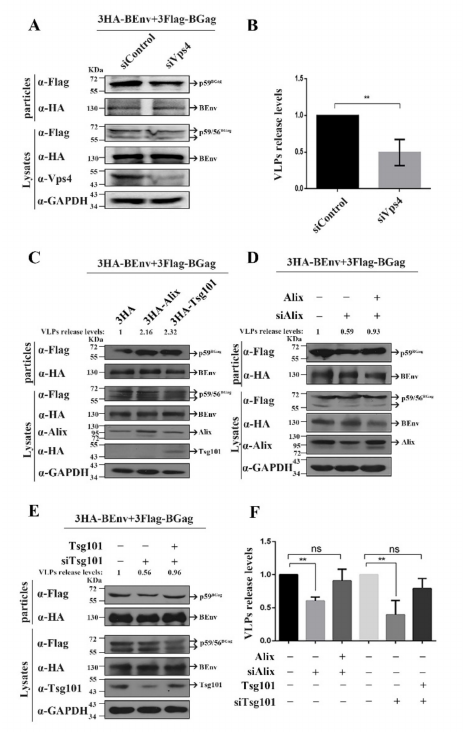
Figure 1. Effect of Vps4, Tsg101, or Alix proteins on particle budding. ( A ) HEK293T (4 × 10 6 ) cells were transfected with si VPS4 or siControl 6 h before being transfected with 3HA-BEnv or 3Flag-BGag (BFV Gag protein), and then cultured for 24 h. The cell culture supernatants were filtered through a 0.45 µ m filter and purified by ultracentrifugation. Transfected cells were lysed using lysis buffer. Levels of proteins in cells and supernatants were measured using Western blot. ( B , F ) To quantify the levels of released VLPs, the amount of BGag in VLPs was normalized against the amount of intracellular BGag, which was first normalized against the GAPDH loading control. Mean values and the standard deviation of particle-associated BGag protein corrected for intracellular expression levels ( n = 3) are shown. The data are the averages of three independent experiments. Compared with the siControl: ** p < 0.01. ( C ) HEK293T (4 × 10 6 ) cells were transfected with 3HA-BEnv, 3FlagBGag, and either the 3HA, 3HA-Alix, or 3HA-Tsg101 vector constructs and harvested at day 2 post-transfection. The cell culture supernatants were filtered through a 0.45 µ m filter and purified by ultracentrifugation. Transfected cells were disrupted using lysis buffer. Levels of proteins in cells and supernatants were measured using Western blotting. ( D ) HEK293T (4 × 10 6 ) cells were transfected with siAlix or siControl 6 h before transfected with 3HA-BEnv, 3Flag-BGag, and either the pCMV-3HA or pCMV-3HA-Alix vector constructs, and then cultured for 24 h. The cell culture supernatants were filtered through a 0.45 µ m filter and purified by ultracentrifugation. Levels of proteins in cells and supernatants were measured using Western blotting. ( E ) HEK293T (4 × 10 6 ) cells were transfected with siTsg101 or siControl 6 h before transfected with 3HA-BEnv, 3Flag-BGag, and either the pCMV-3HA or pCMV-3HA-Tsg101 vector constructs, and then cultured for 24 h. The cell culture supernatants were filtered through a 0.45 µ m filter and purified by ultracentrifugation. Levels of proteins in cells and supernatants were measured using Western blotting. The levels of released VLPs were quantified according to the method described in the statistical analysis